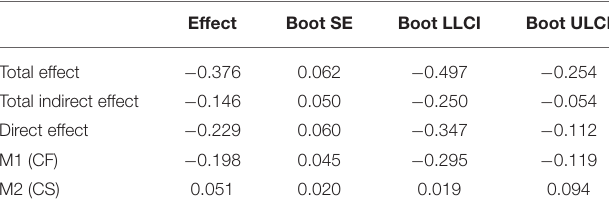
TABLE 5 | Intermediary analysis